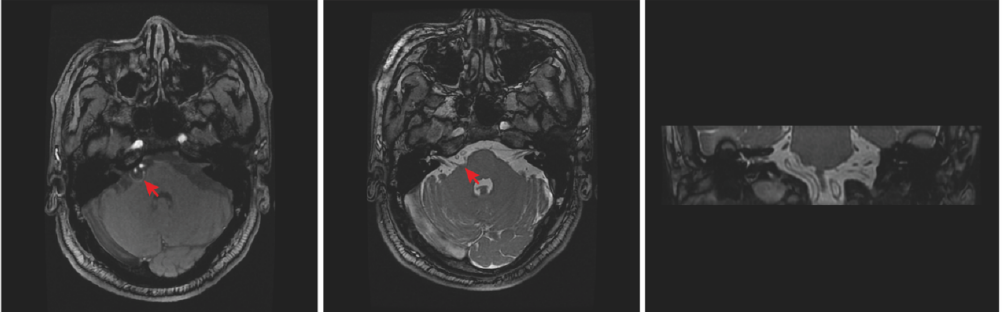
Figure 1. Preoperative MRTA showed that a cluster of cerebellar arteries compressed the root of the right facial nerve, but no sign of tumors was found (red arrowhead, left panel). The corresponding COSMIC sequence MRI at the same level was also provided (middle panel: axial section; right panel: coronal section).